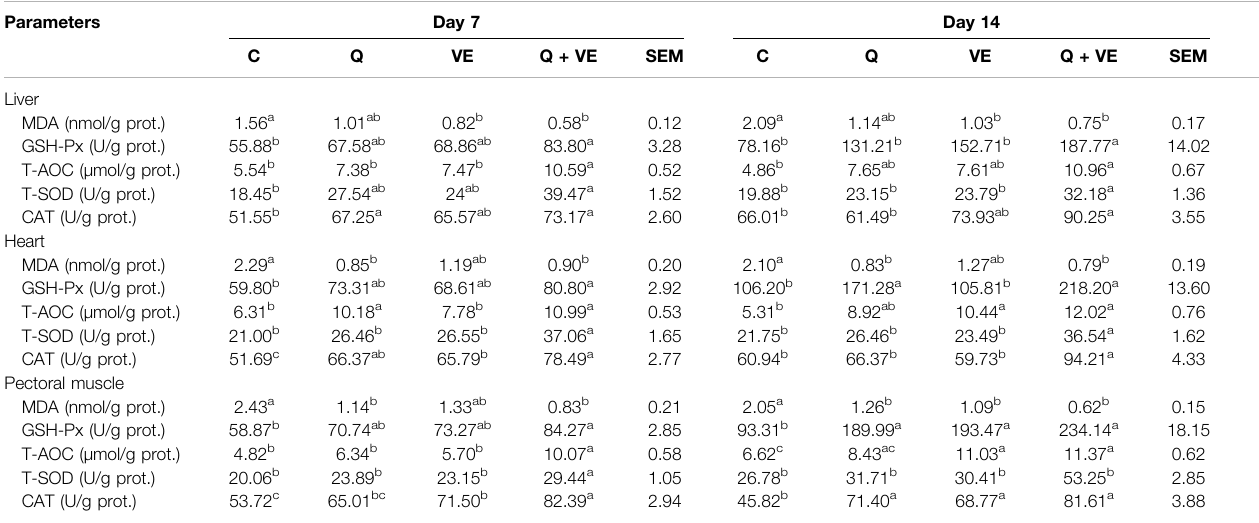
TABLE 6 | Dietary effects of Q, VE, and Q + VE on the antioxidant status of the embryo. Parameters Day 7 Day 14